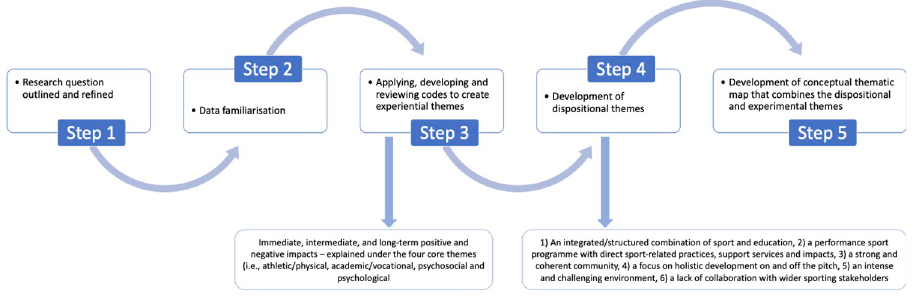
Fig 1. Thematic analysis